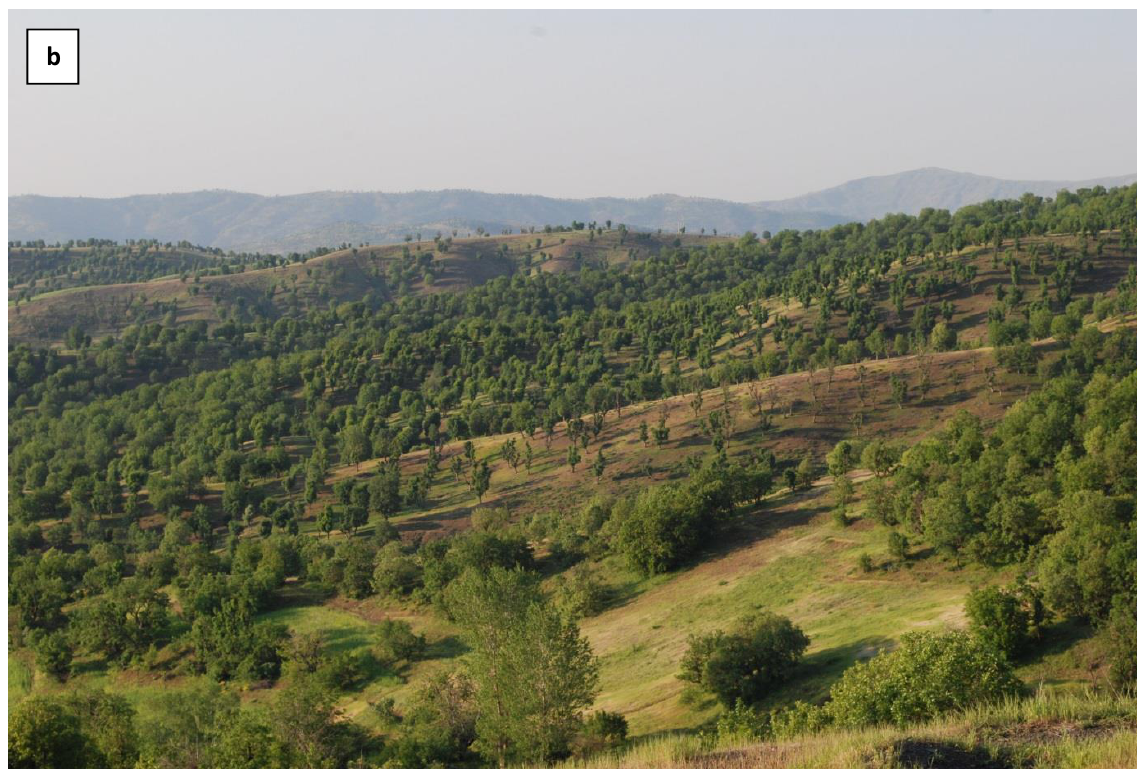
Figure A1.1: (a) A sacred grove surrounded by traditional farmland and woodland and (b) Silvopastoral woodland of traditionally pollarded